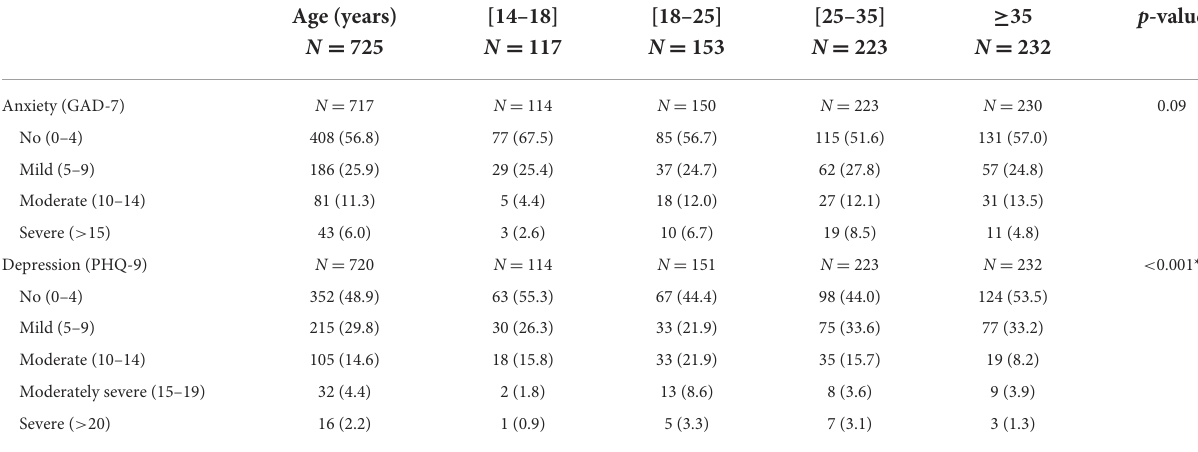
TABLE 4 Anxiety and depression during lockdown period.